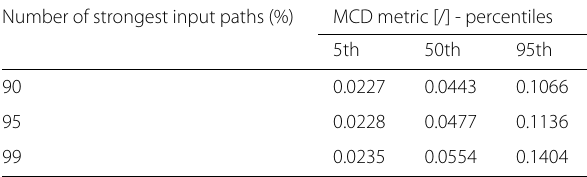
Table 1 Percentiles of the MCD metric as a function of the number of strongest input propagation paths Number of strongest input paths (%) MCD metric [/] - percentiles